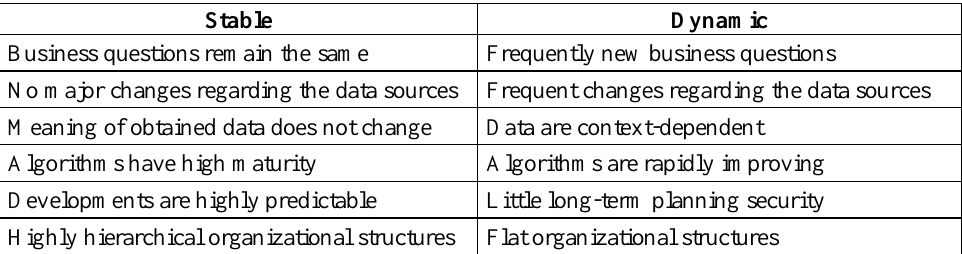
Table 4. Factors influencing the character of a big data analytics solution